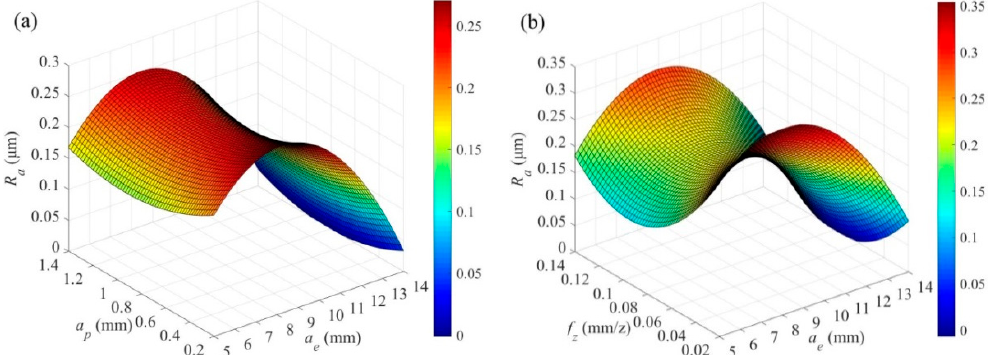
Figure 12. The interaction of ( a ) a e × a p ( V c = 80 m/min, f z = 0.06 mm/z), and ( b ) a e × f z ( V c = 80 m/min, a p = 0.6 mm) on surface roughness R a .